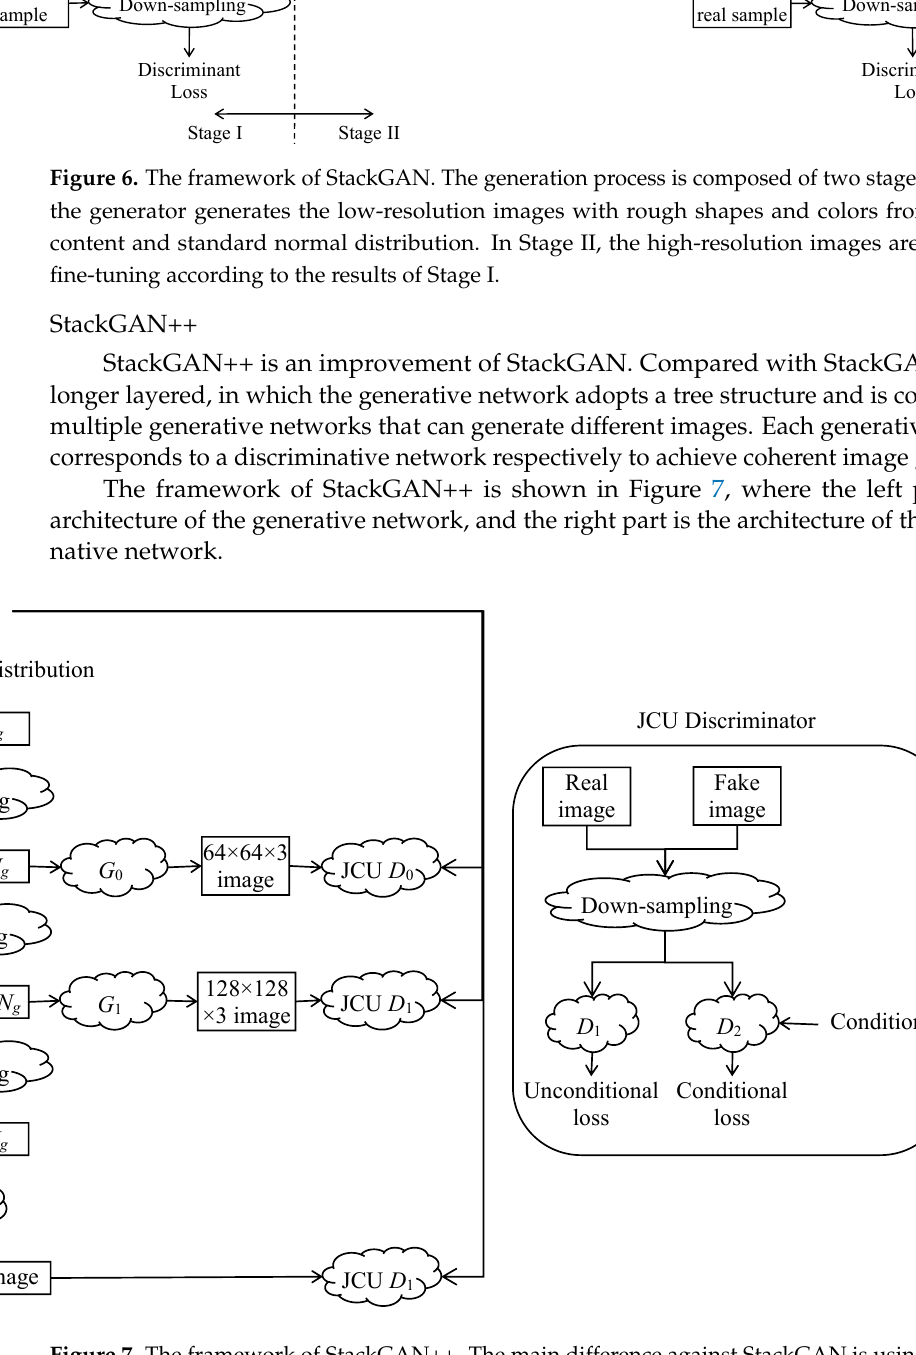
Figure 7. The framework of StackGAN++. The main difference against StackGAN is using more than one generative network and discriminative network. These networks form a tree, different branches of which correspond to different scales in the same